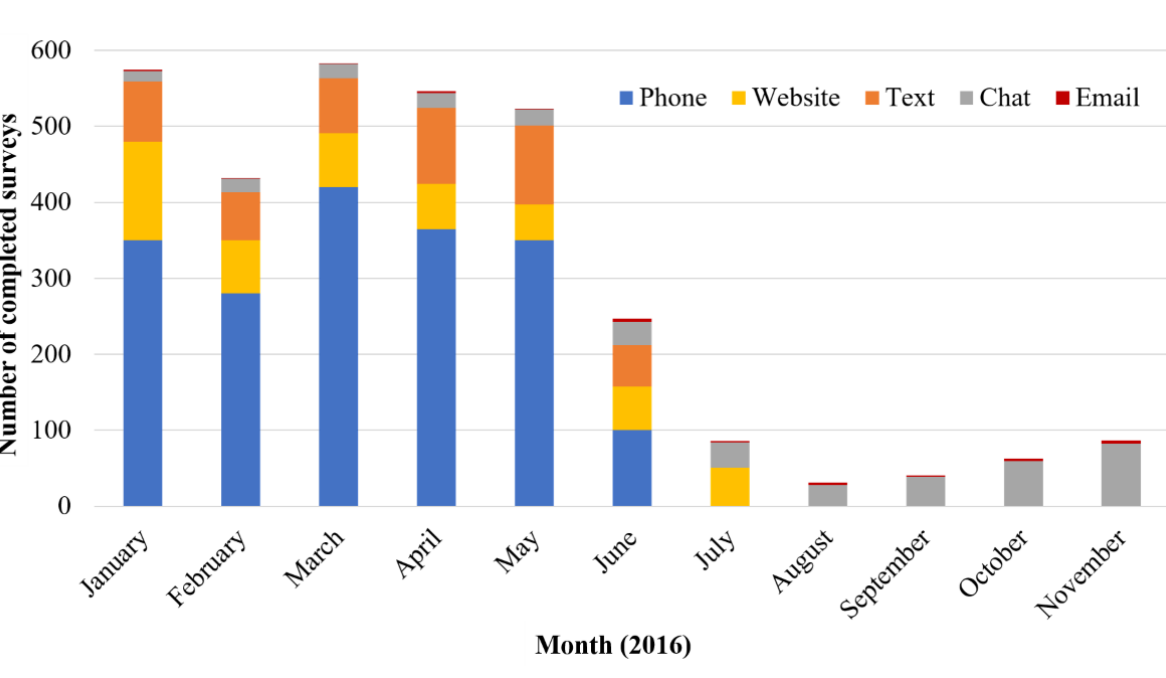
Figure 1. Number of completed Cancer Communication Channels in Context Study surveys per month by recruitment channel, January-November 2016 (accrual goals for phone and text message recruitment were reached in June; accrual goal for website recruitment was reached in